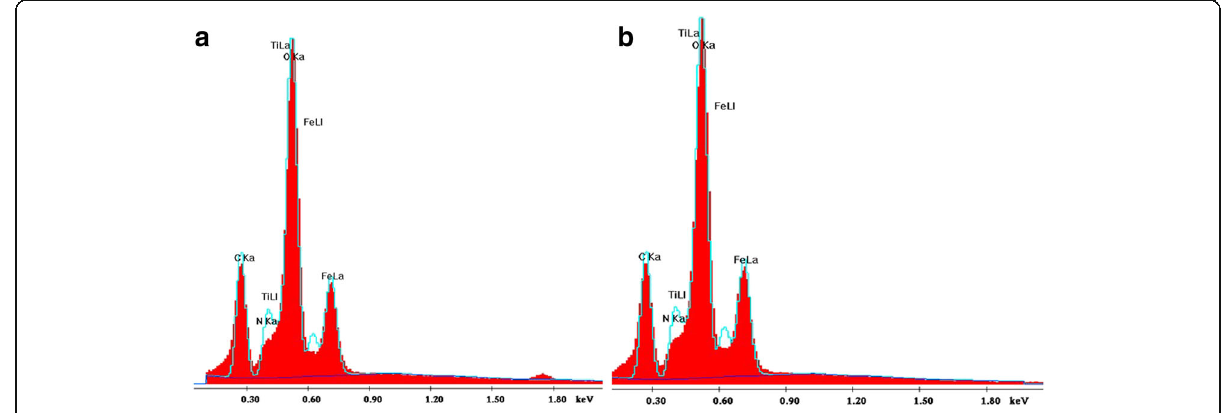
Fig. 5 EDS images of Fe x Ti y O z ( a ) and N/Fe x Ti y O z ( b ) films treated at 450